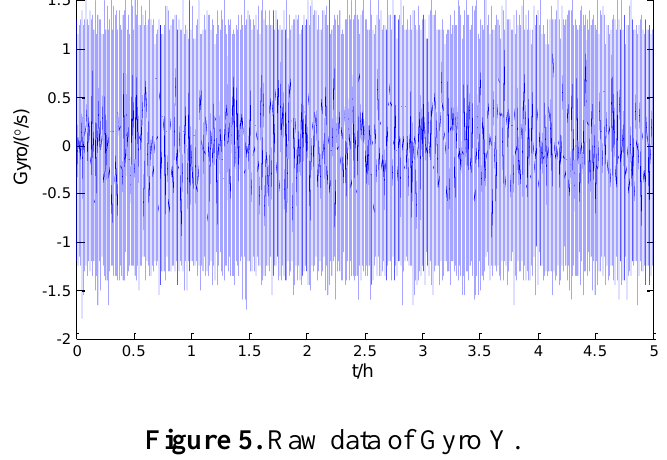
Figure 5. Raw data of Gyro Y.